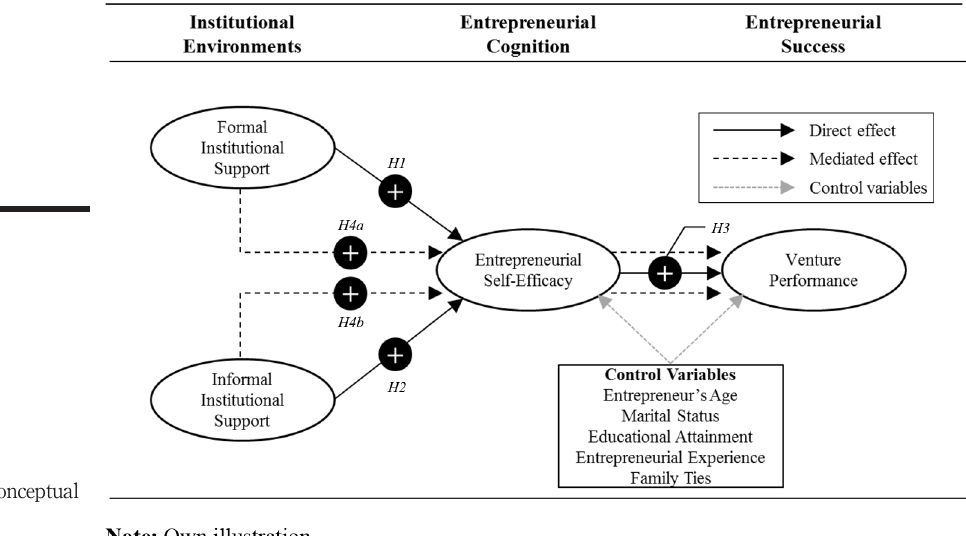
Figure 1. Proposed conceptual